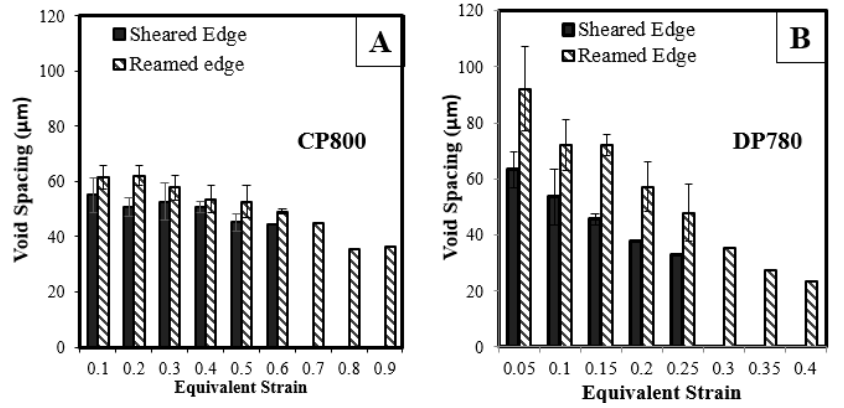
Figure 22. Variation of the void spacing with equivalent strain for ( A ) CP800; and ( B ) DP780. The void area fraction (porosity) is equivalent to the total area of voids divided by the total section